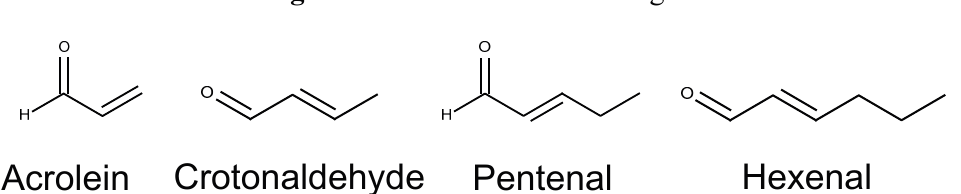
Figure 5. Acrolein and its